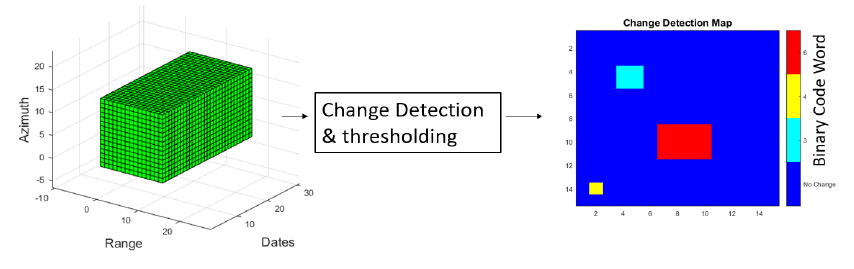
Figure 1. Multi bi-date change